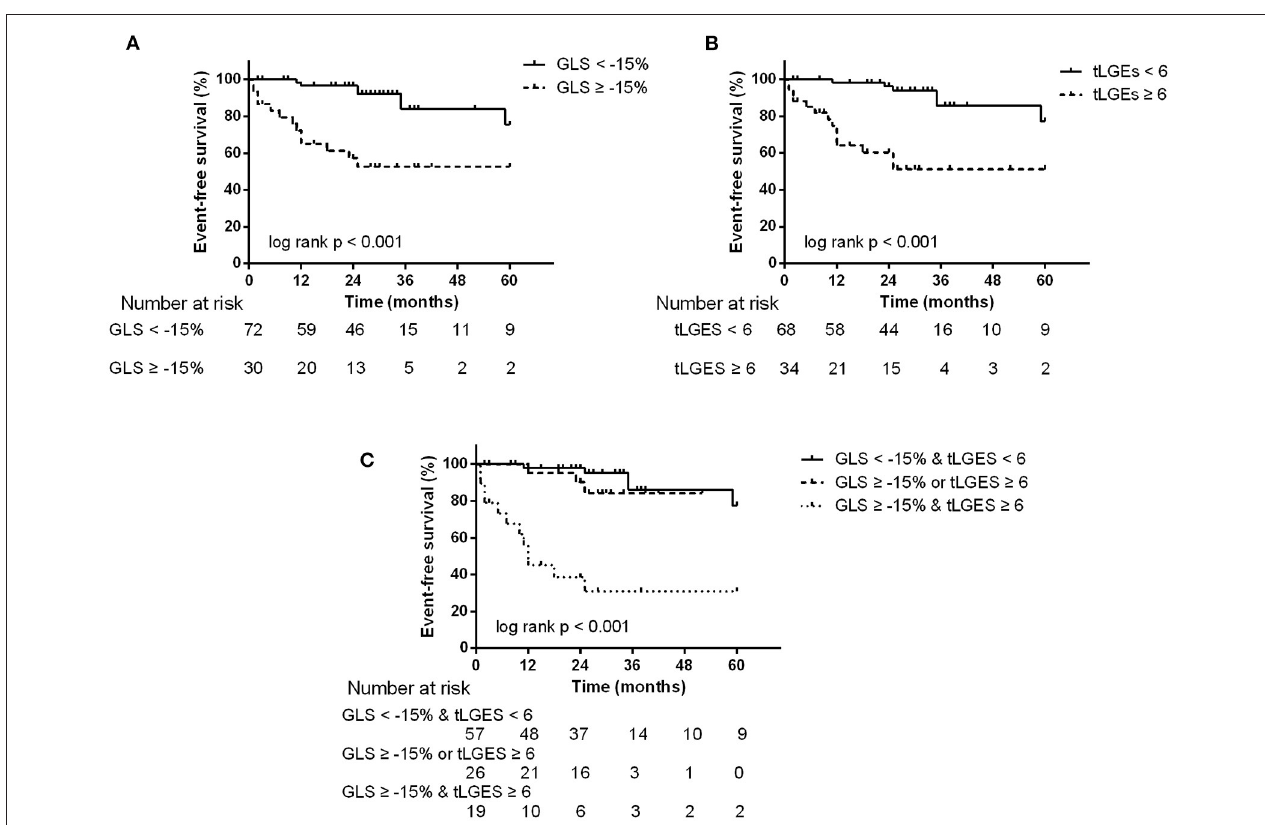
FIGURE 3 | Kaplan-Meier survival curves stratified by abnormal GLS (A) , tLGEs (B) , and combined GLS and tLGEs (C) . Patients with both impaired GLS and high tLGEs had predominantly reduced event-free